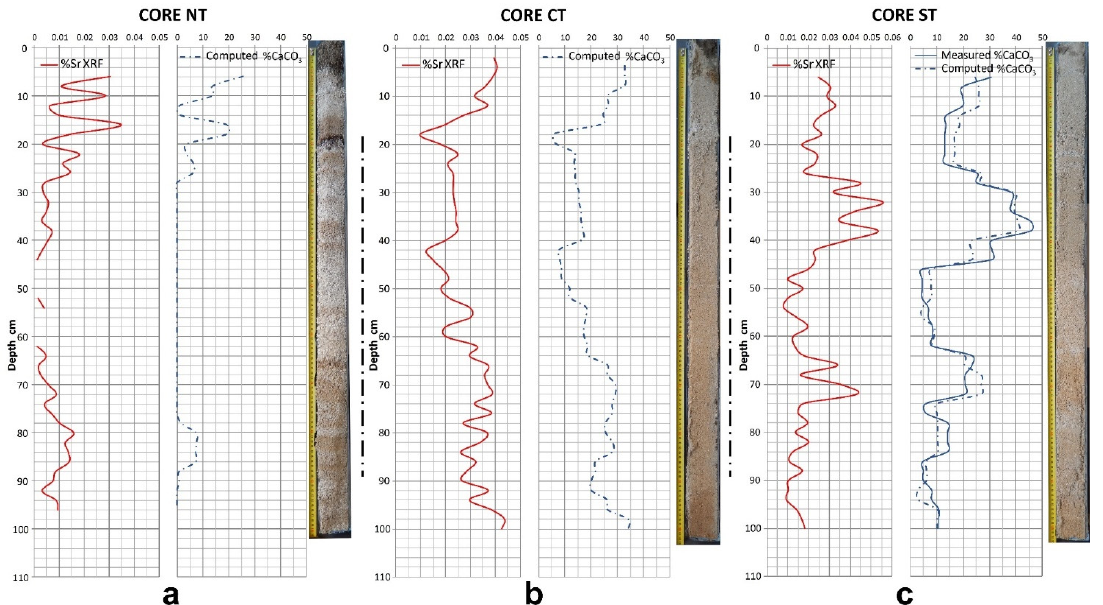
Figure 6. Core logs and core photos for the three wells representing %XRF from pXRF tool, computed carbonated content and for core ST, also measured carbonate content from sediment; ( a ) %XRF from pXRF tool and computed carbonated content along NT; ( b ) %XRF from pXRF tool and computed carbonated content along CT; ( c ) %XRF from pXRF tool, measured carbonate content and computed carbonated content along ST.